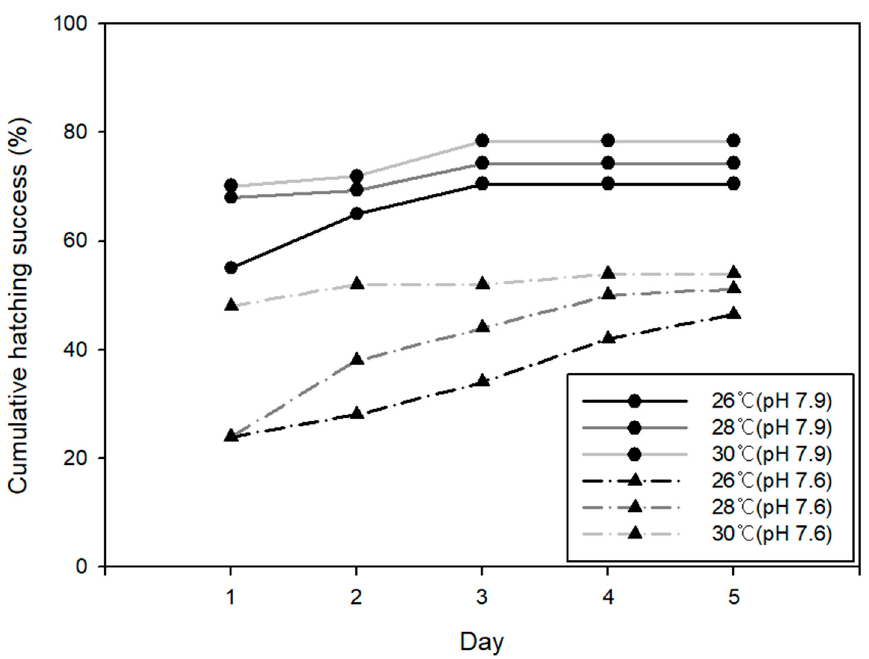
Figure 5. Hatching success of Acartia ohtsukai eggs over time when maintained under two different pH and three different temperature conditions.